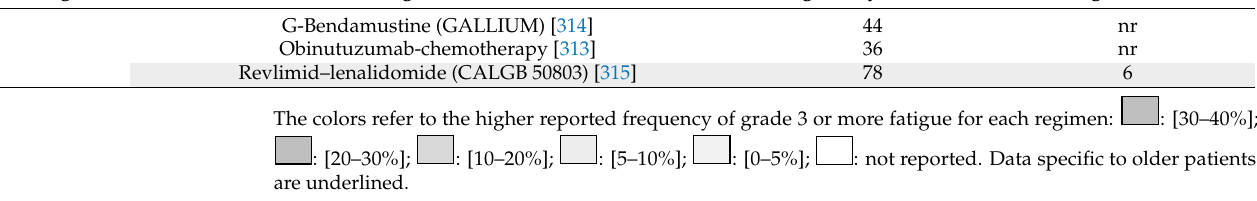
Table 6. Cont. Setting Treatment Regimen and